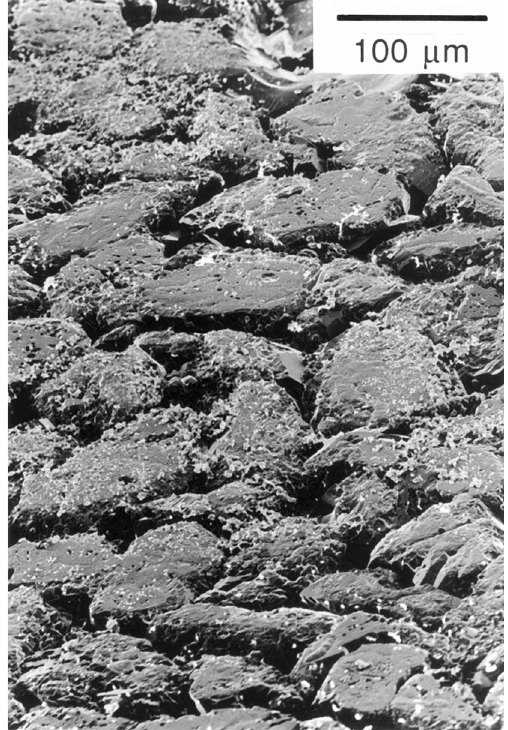
Figure 3. SEM micrograph showing top surface of the truncated quartz crystals after removal of the polished quartz plate. Note flat top surface of the